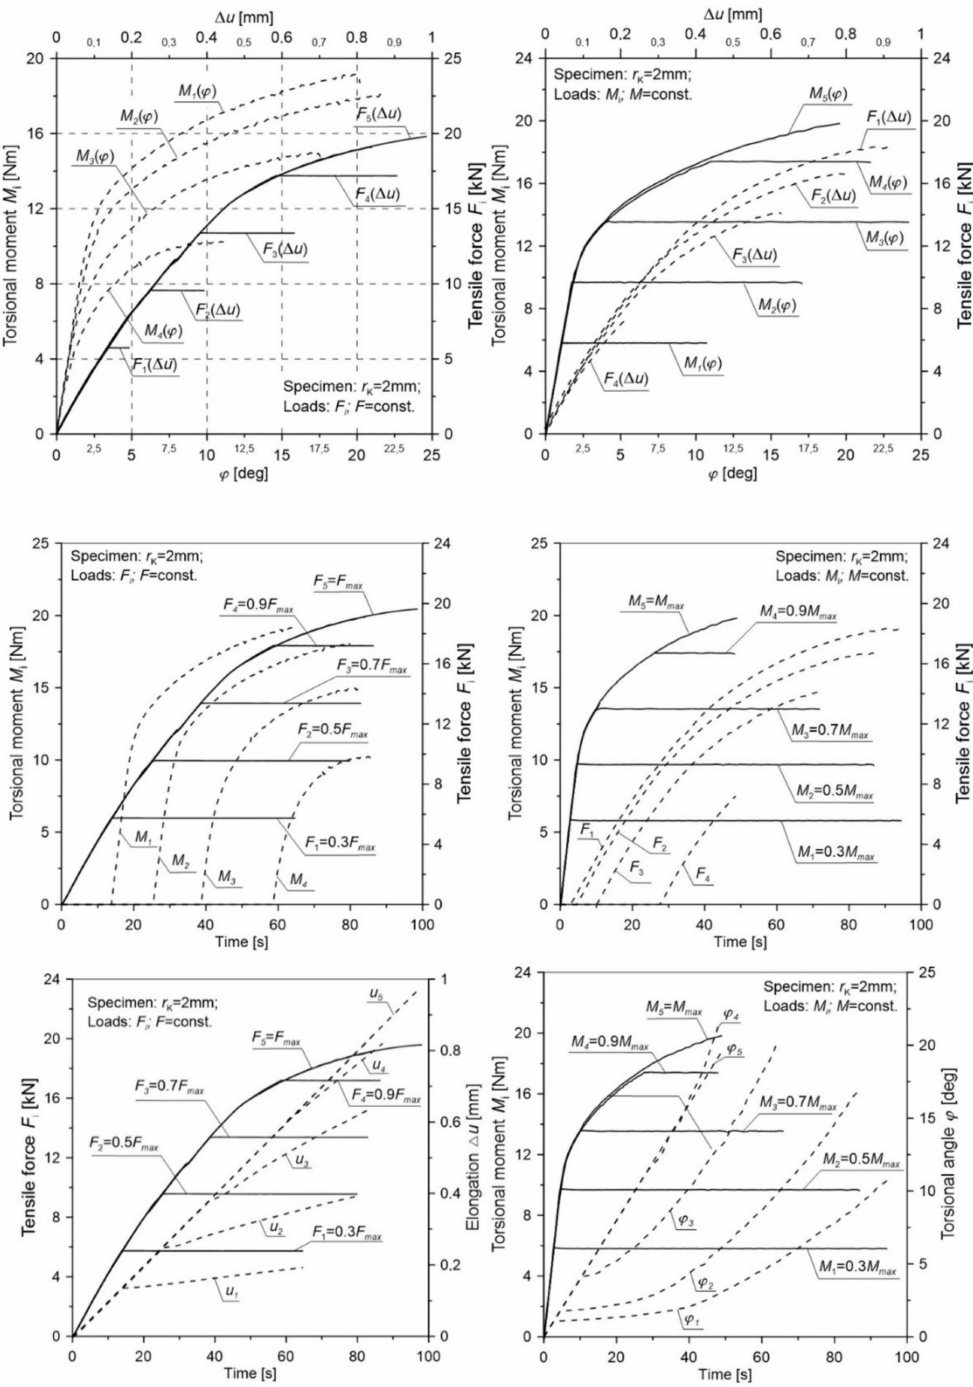
Figure 9. The distribution of the tensile force, torsional moment, elongation, and torsional angle of the gauge length of a notched specimen with a radius r K = 2 mm for various load